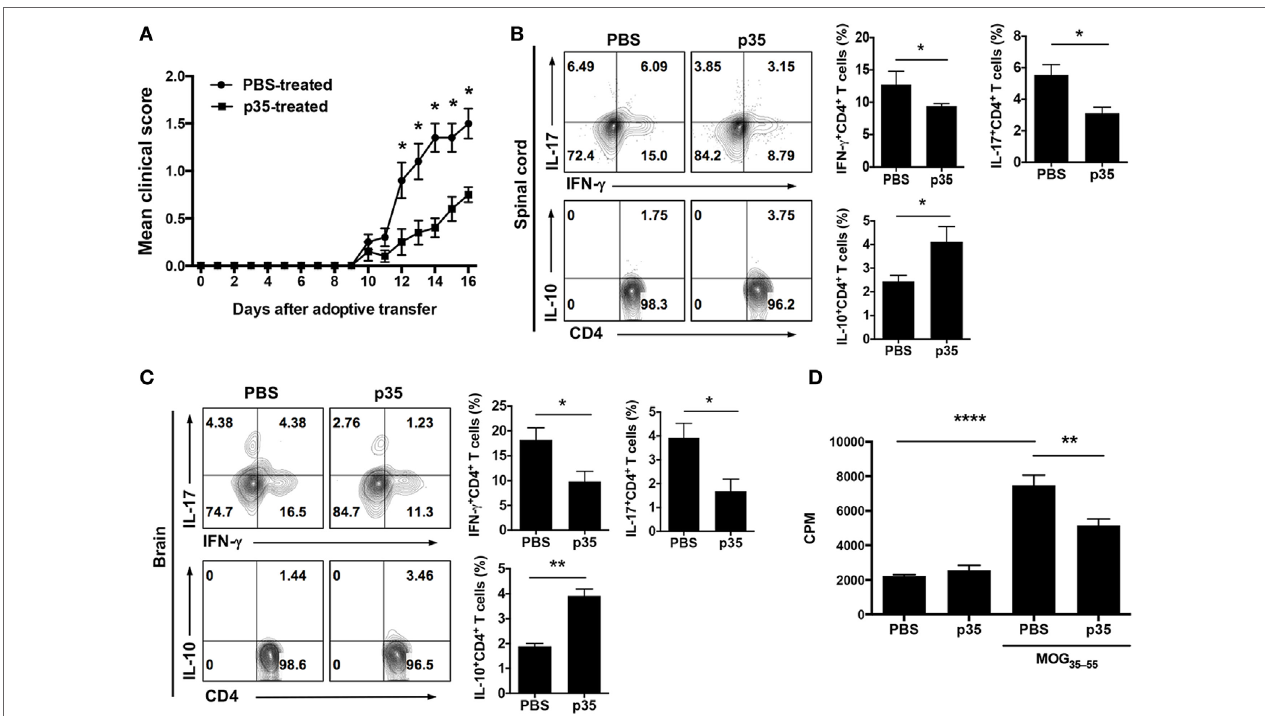
FigUre 3 | IL-12p35 treatment suppressed adoptive transfer of experimental autoimmune encephalomyelitis (EAE) by encephalitogenic T cells. EAE was induced in mice by active immunization with MOG 35–55 -peptide in complete Freund’s adjuvant, and the mice were treated with p35 or PBS. Spleen cells from the mice on day 17 after EAE induction were restimulated ex vivo with MOG 35–55 for 72 h. Activated cells (1 × 10 7 cells/mouse) were transferred to naïve syngeneic mice and clinical disease monitored until day 17 days after adoptive transfer of encephalitogenic cells. (a) EAE clinical scores. (B,c) On day 17 after adoptive transfer, cells were isolated from the brain or spinal cord and analyzed by intracellular cytokine staining. Cells were gated on CD4 + cells, and numbers in quadrants indicate percentage of cells IFN- γ -, IL-17-, and IL-10-expressing CD4 + T cells. (D) Proliferative responses of cells in the spinal cord and brain of C57BL/6J recipient mice 17 days after adoptive transfer were assessed by 3 H-thymidine incorporation assay. Five replicate cultures were analyzed, and data presented as mean value of CPM of the five replicate cultures. The data are presented as the mean ± SEM of three determinations. **** p < 0.0001; *** p < 0.001; ** p < 0.01; * p < 0.05, significantly different from adoptive transfer of MOG 35–55 -stimulated with